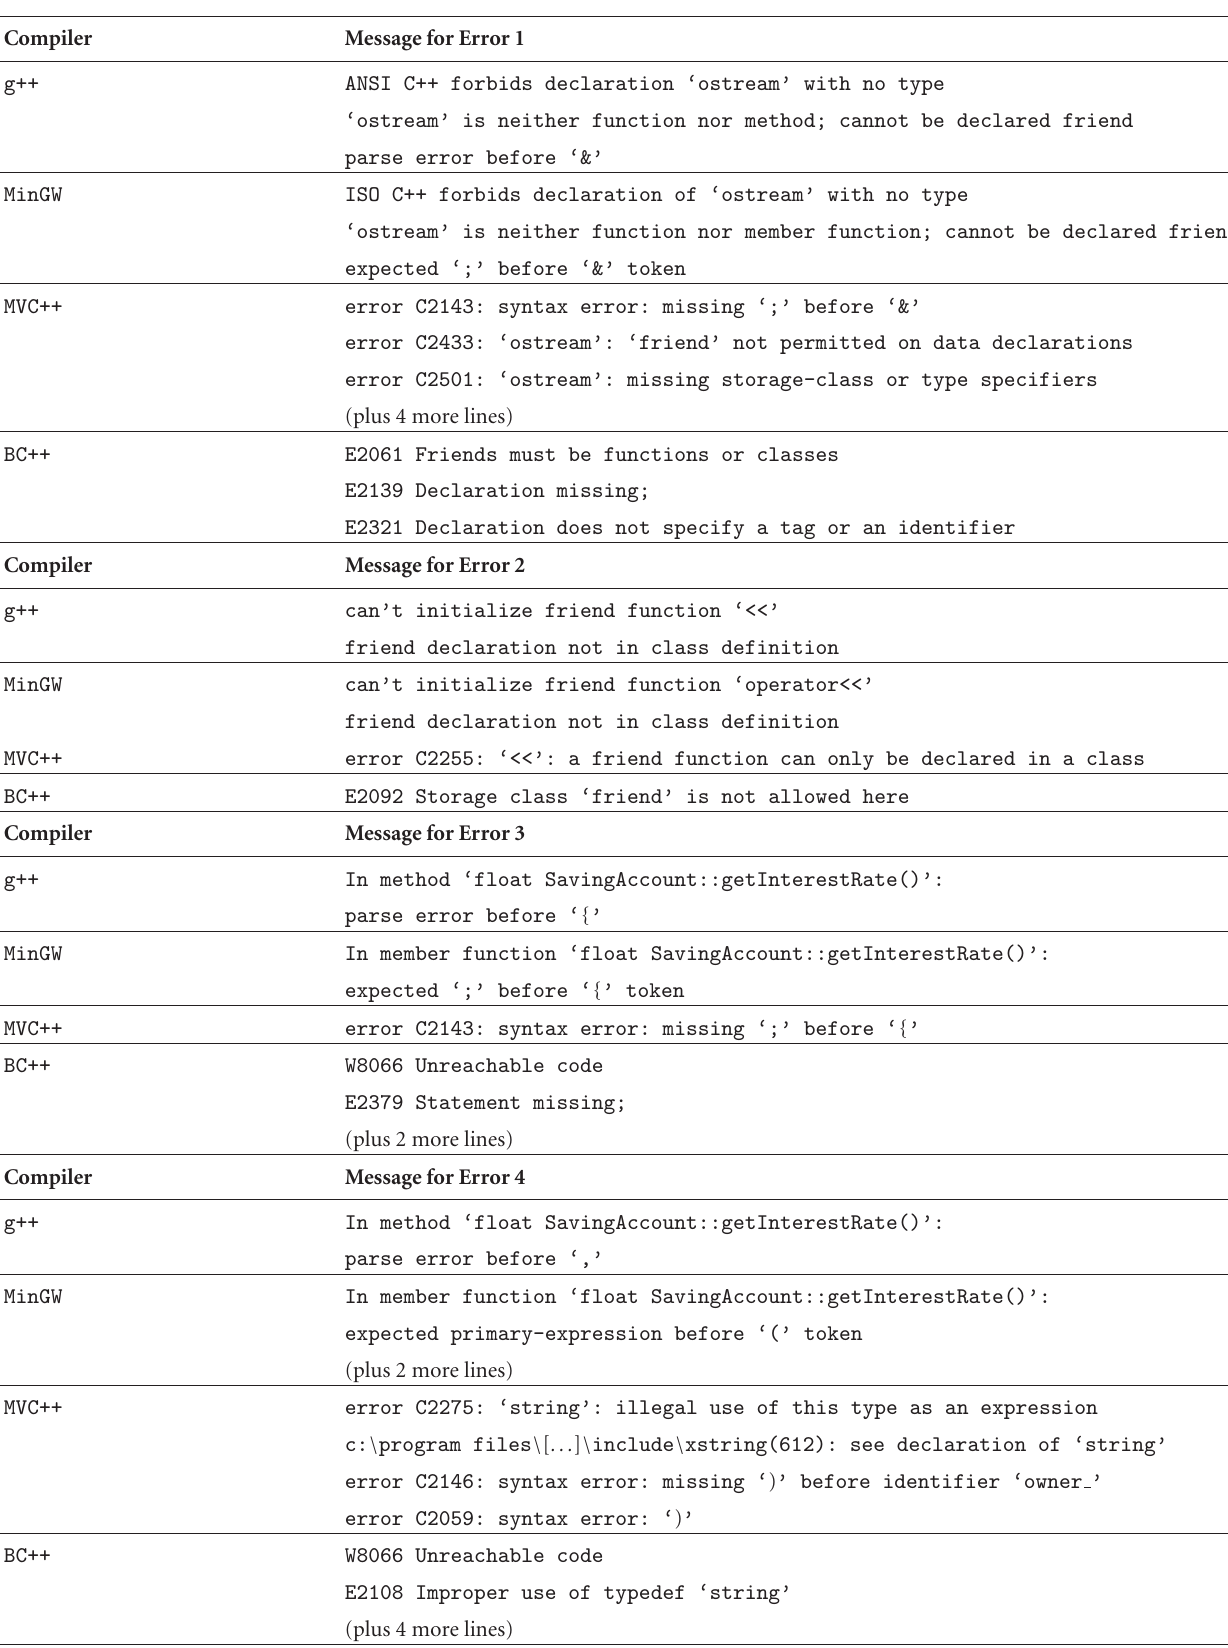
Table 3: Error messages of four di ff erent C++ compilers for Errors